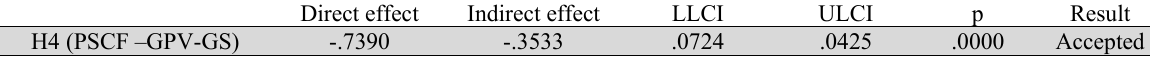
Effect of PSCF on Guests’ Satisfaction through the mediating effect of Guests’ perceived value (H4)